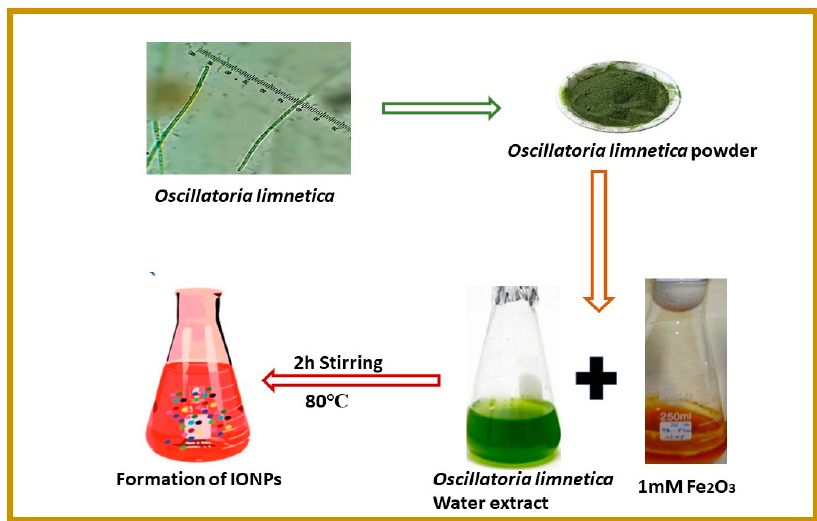
Figure 1. Novel protocol showing green synthesis of Oscillatoria limnetica- mediated IONPs.